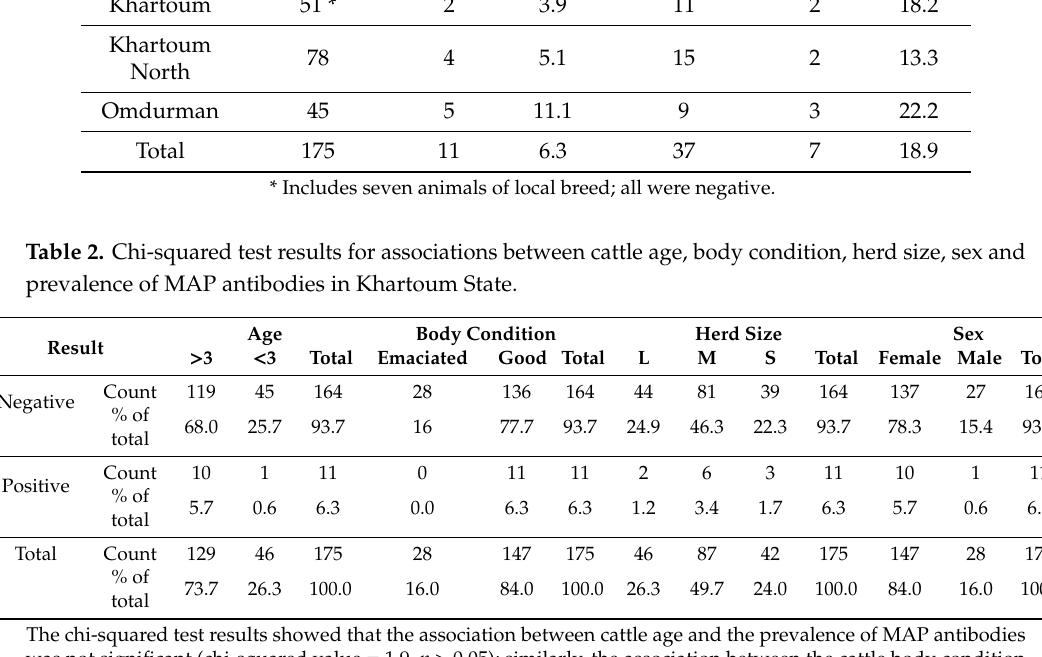
Table 1. Prevalence of MAP antibodies in dairy cattle in Khartoum State. Animal Level Herd Level Area Positive No. Tested No. Tested